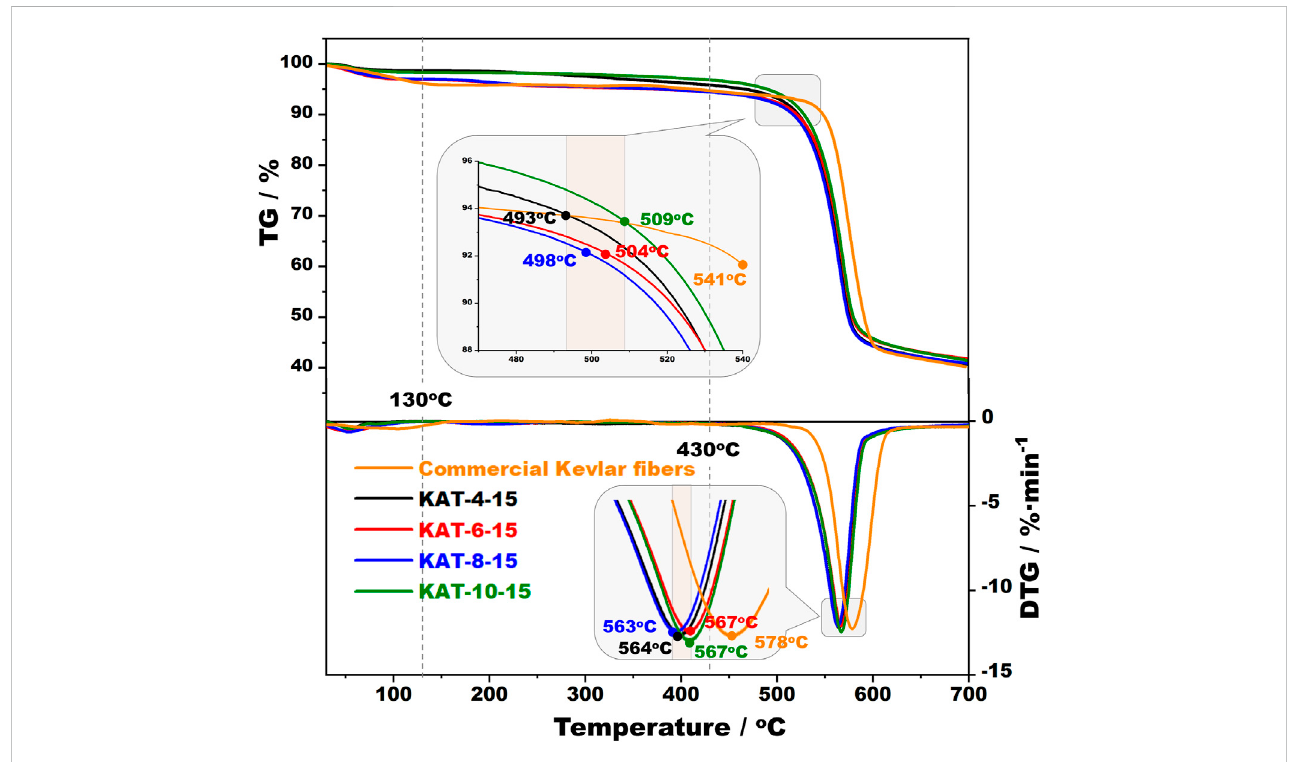
FIGURE 6 TG and DTG curves of commercial Kevlar fi bers and the aerogel tapes fabricated from different Kevlar concentrations.